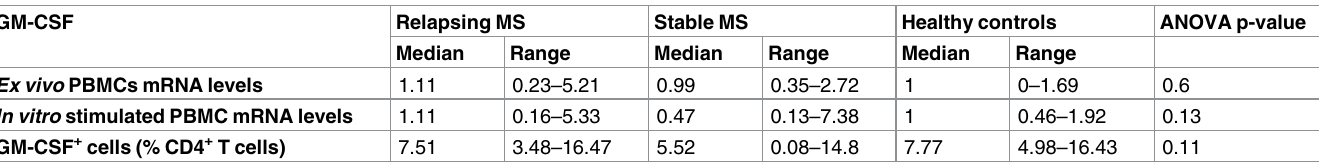
Table 2. GM-CSF expression analysis in PBMCs of MS patients and HC.